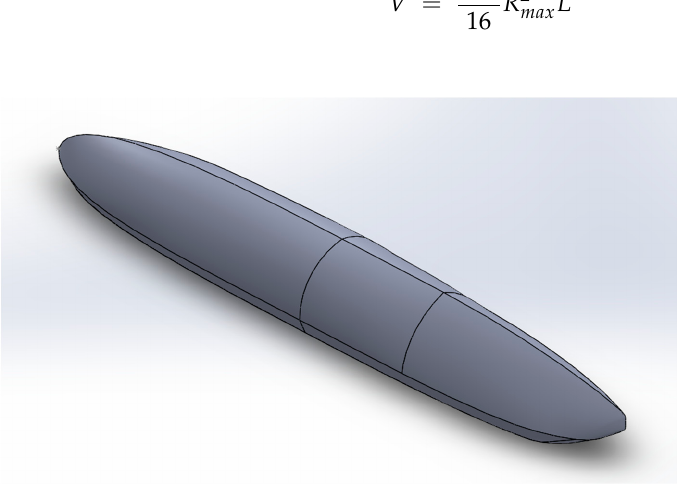
Figure 4. Isometric view of the Phase-1 model.